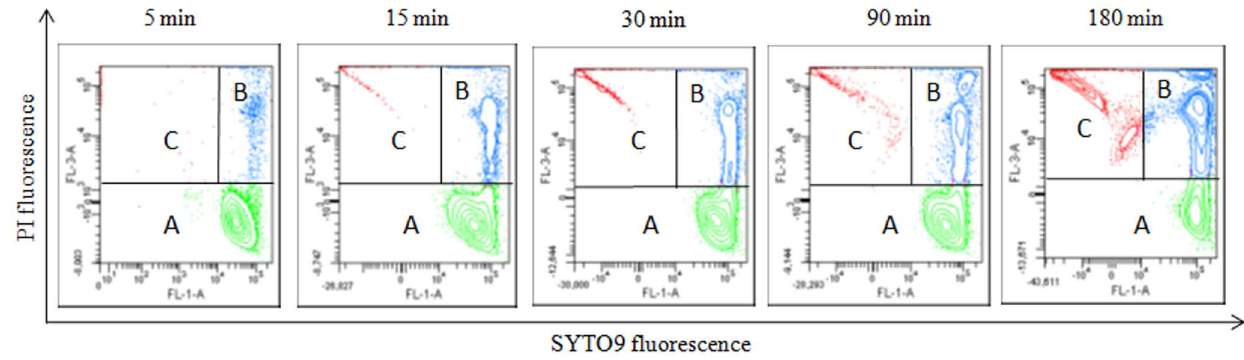
Figure 5. Flow cytometric SYTO 9 (FL1)/PI (FL3) dot plots presenting pH-dependent E.coli membrane damage. Data obtained for a representative ETEC sample incubated with glycine (50 mM, pH 9.5) for up to 3 hours. The A region corresponds to the subpopulation of live cells with an intact plasma membrane, the B region corresponds to the subpopulation of bacteria in an intermediate injured state with different degrees of comprised membranes, the C region corresponds to the subpopulation of dead cells with irreversibly damaged membranes.